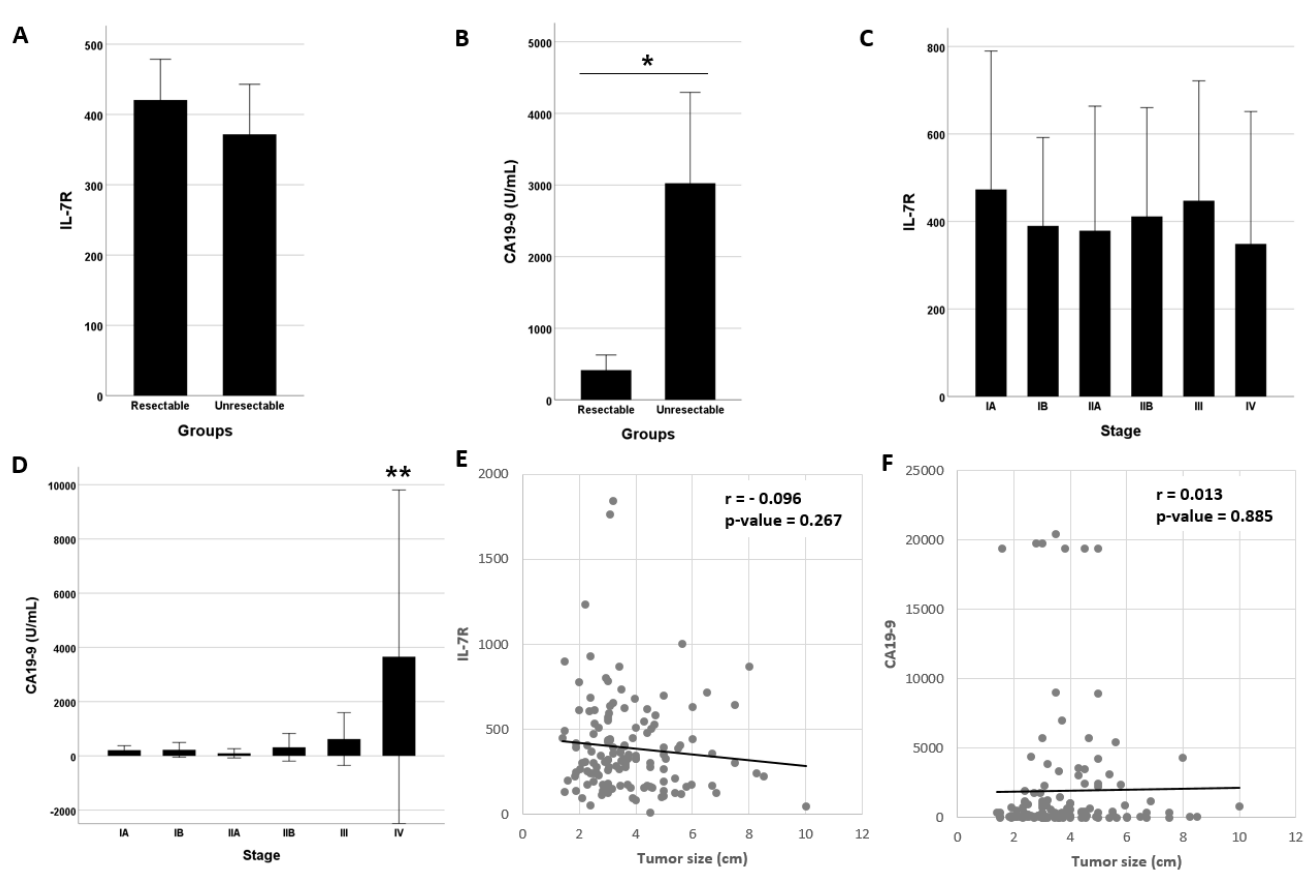
Figure 3. IL-7R and CA19-9 levels in patients with PDAC. ( A ) IL-7R levels did not differ between patients with resectable and unresectable PDAC. ( B ) CA19-9 levels were higher in patients with unresectable PDAC than in those with resectable PDAC. ( C ) IL-7R levels did not differ according to the PDAC stage. ( D ) CA19-9 levels were higher in patients with stage IV PDAC than in those with PDAC of other stages. ( E ) IL-7R levels decreased non-significantly with increasing tumor size. ( F ) CA19-9 levels increased non-significantly with increasing tumor size. * p < 0.005, resectable vs. unresectable PDAC. ** p < 0.005, stage IV vs. stages I–III PDAC.